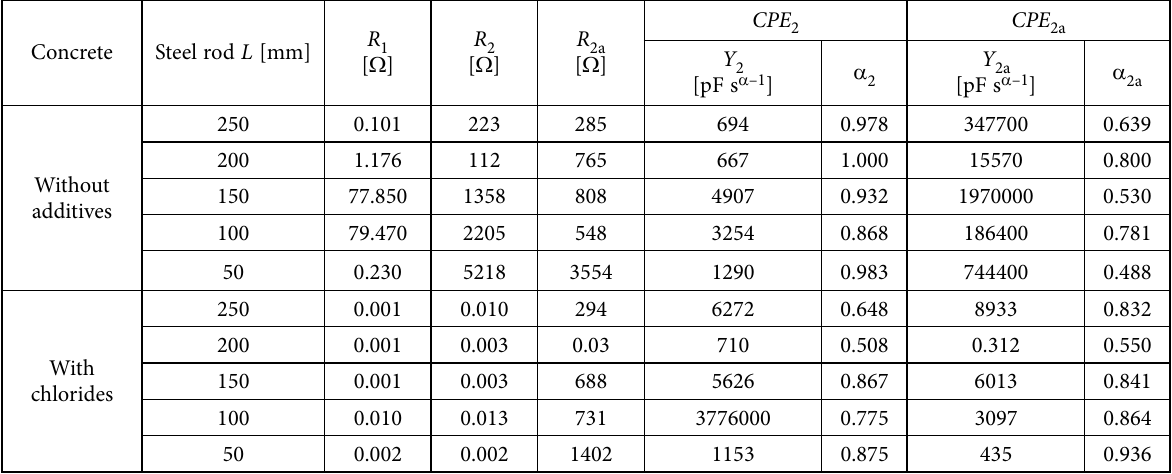
Table 1. The results of impedance spectra analysis – characteristics of concrete